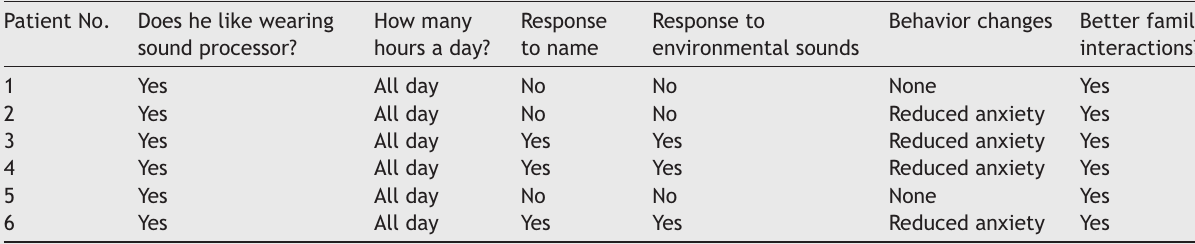
The questionnaire results. The parents responded to the following questions: (1) Does your child willingly uses the sound processor?; (2) How many hours a day the sound processor is on?; (3) Does the child respond to his/her name in quiet with auditory cues only (no visual cues)?; (4) Does the child spontaneously alert to environmental sounds?; (5) Is the child’s behavior affected while wearing his/her sound processor?; and (6) Does the family interactions with the child and within the family benefited from implant? (The same order of questions is kept in the table). Patient